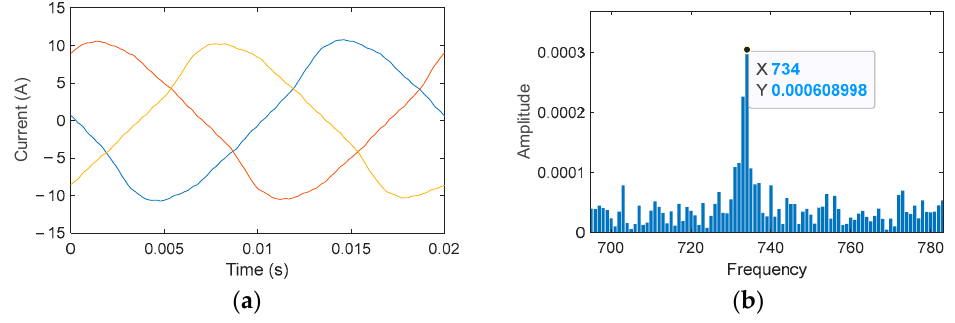
Figure 4. Measured stator current and rotor harmonic frequency: ( a ). measured phase-A currents; ( b ). extracted rotor slot harmonics frequency (734 Hz) for 5.5 kW motor, with slot number Z = 28 and pole pair number p = 2; the corresponding speed is 1465.71 r/min after recorded data analysis.